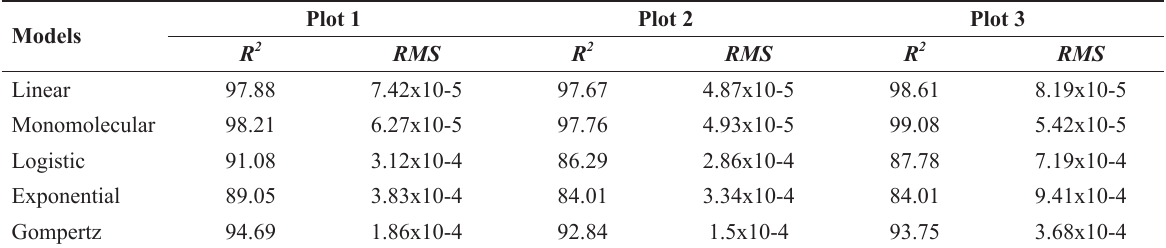
Coefficient of determination between predicted and observed values ( R 2 ) and residual mean square ( RMS ) of models for incidence of coconut stem bleeding in Platô de Neópolis, state of Sergipe.